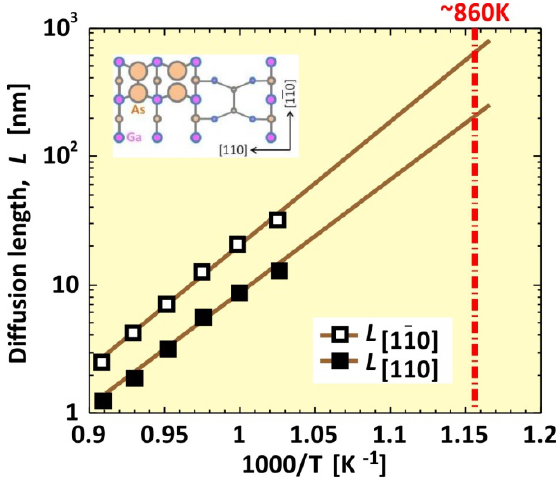
8. Ga diffusion length, L , as a function of reciprocal temperature at p = 1.4 × 10 − 6 Ga